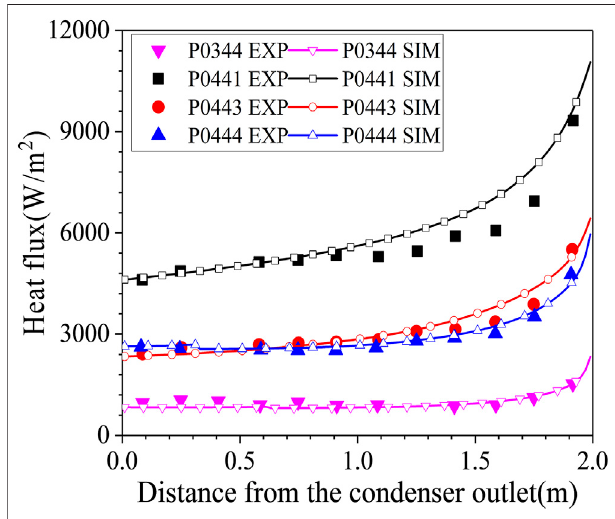
FIGURE 14 | Modi fi ed HMTA model compared with COPAIN experimental